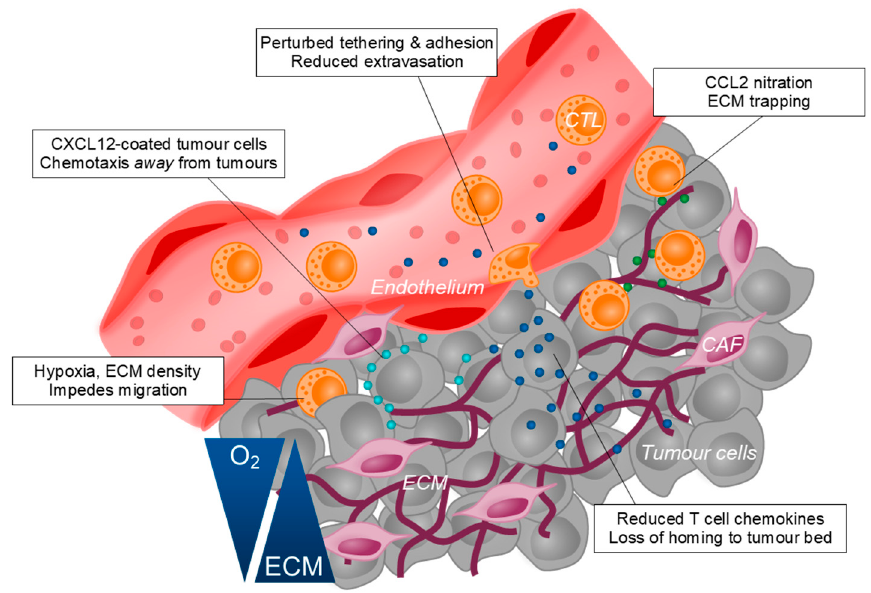
Figure 2. The TME perturbs multiple mechanisms of T cell migration to avoid immune surveillance. Cancer cells can impede with CTL trafficking to the tumour bed at multiple levels including the loss of extravasation capacity, disrupted chemokine gradients and physical constraints including increased ECM deposition and poor oxygen availability.